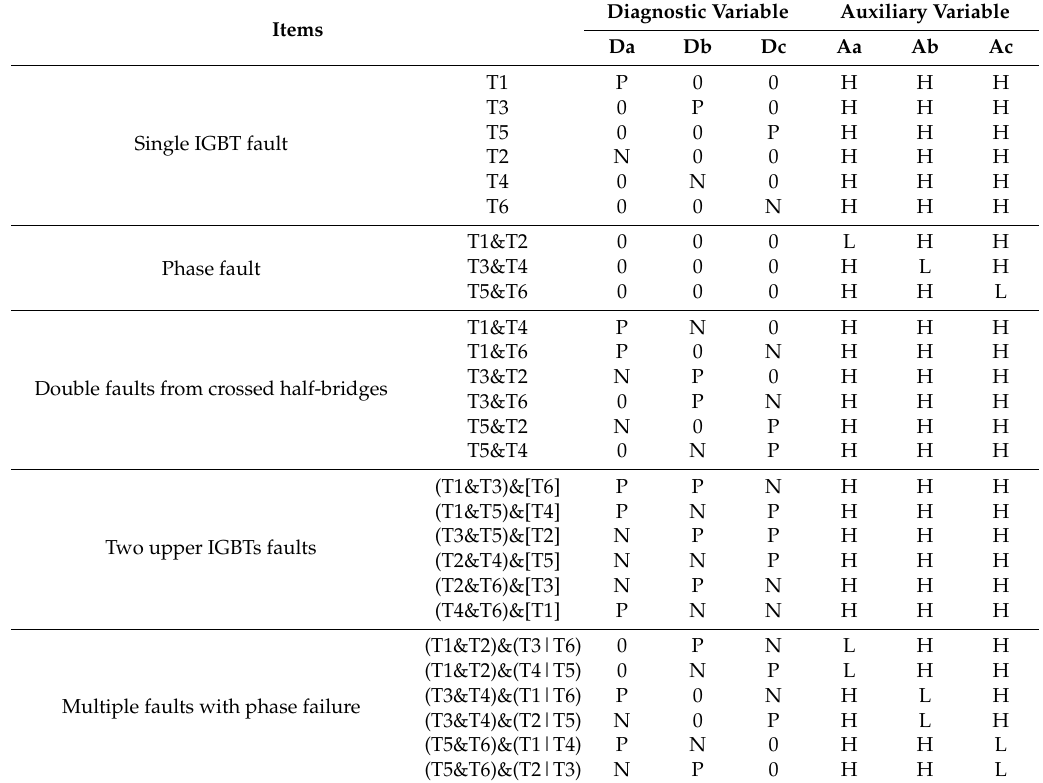
Table 2. Localization of multiple insulated gate bipolar transistor (IGBT) open circuit